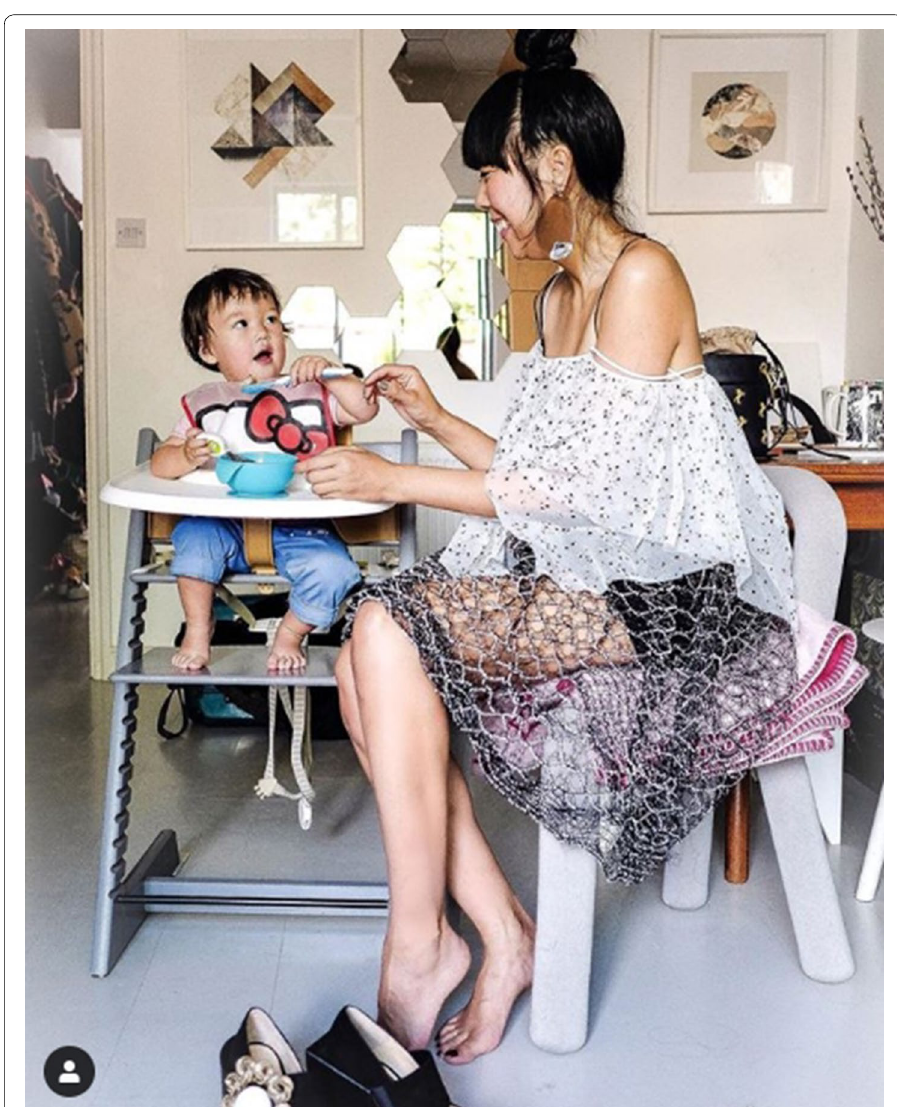
Fig. 6 Babysitting and Serpentine summer party. https ://www.insta gram.com/p/Bkiir 07hHj O/. Accessed 14 September